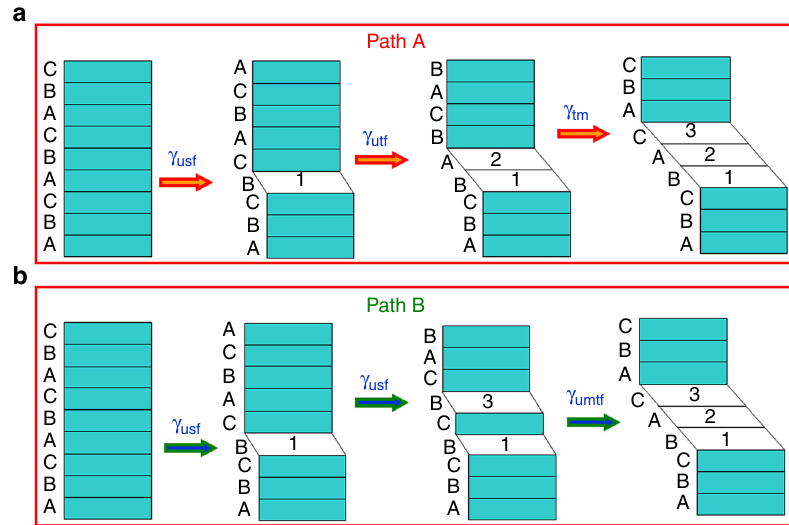
Fig. 3 Schematic illustration of the traditional and new twin nucleation routes. a In the traditional twinning route (path A), twin nucleation involves the sequential nucleation of three partial dislocations and accordingly three SFs on consecutive atomic layers. The highest energy barrier for path A is the unstable twin-fault energy γ utf . b In the new twinning route (path B), two partial dislocations (i.e., two SFs) are present, but they are separated with one atomic layer in between; then a third partial dislocation forms in between the two previously formed SFs, resulting in a three-layer twin. The highest energy barrier becomes the unstable middle-twin-fault energy γ